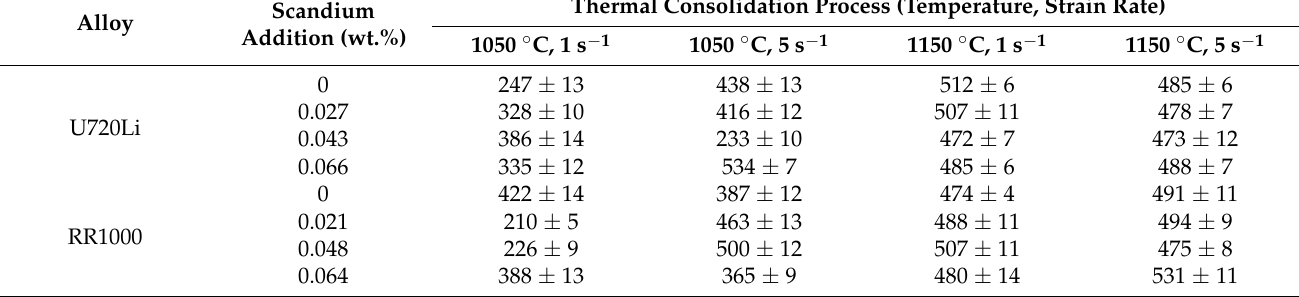
Table 3. Hardness of superalloys with different scandium addition under different thermal consoli- dation processes (HV3).